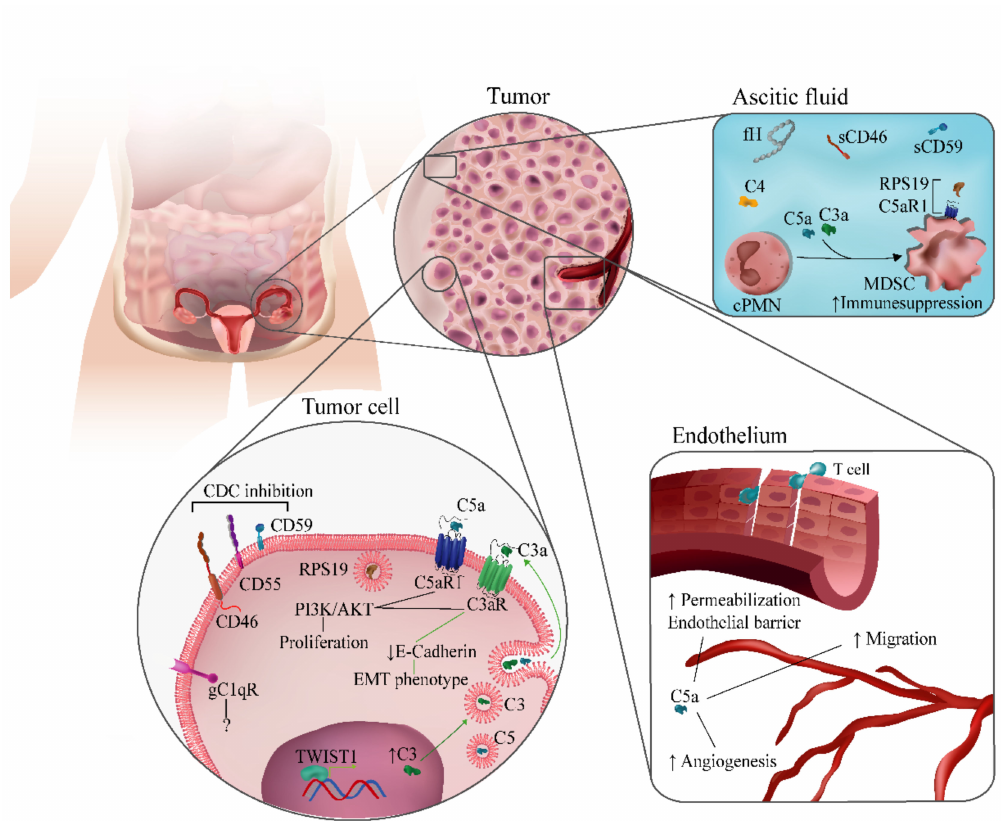
Figure 2. Complement-related mechanisms associated with ovarian cancer progression. Complement components have been implicated in different biological processes associated with ovarian cancer progression. They include modulation of immunosuppression in the tumor microenvironment; regulation of angiogenesis and endothelial permeabilization; autocrine and paracrine effects in tumor cells mediated by C1q, C3a, or C5a; and inhibition of complement-dependent cytotoxicity (CDC) by membrane-bound complement